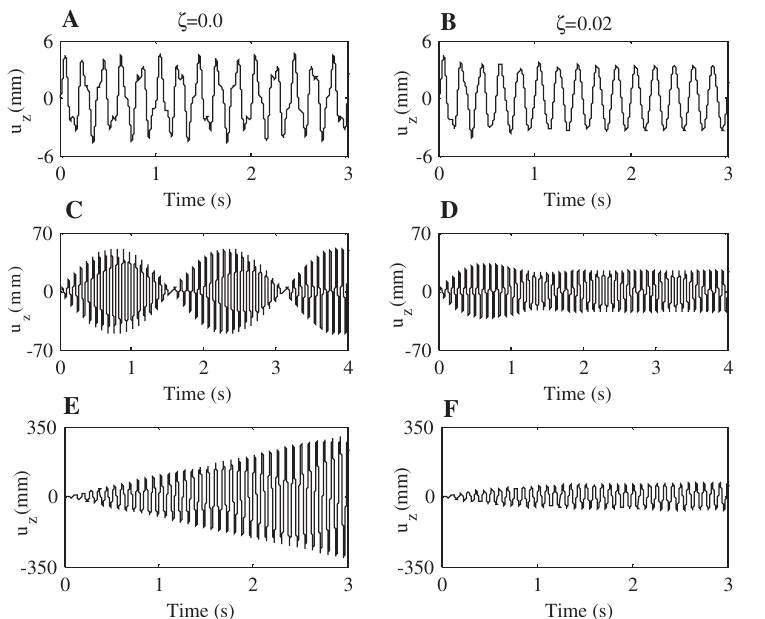
lay-up at (A, B) f = 5 Hz, (C, D) 11.5 Hz, and 2s